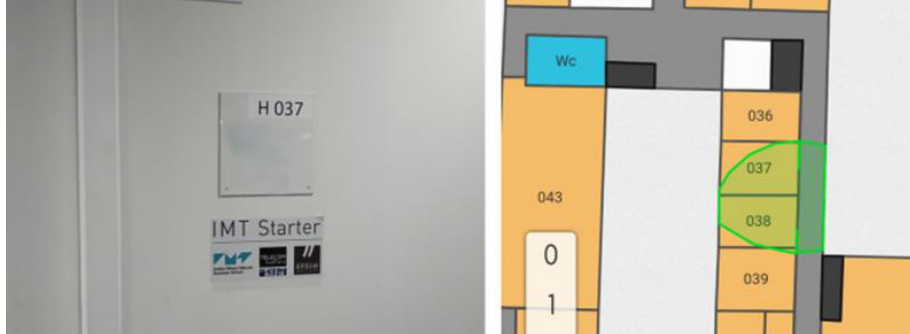
Figure 4. The principle of coupling mapping and location: the green surface is the resulting location which does not require any calibration or model design. On the left is the “visual” location of the tag, and on the right is the area calculated by the system (in green).